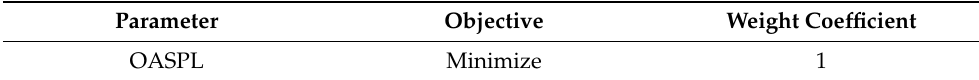
Table 4. Optimization objective settings.